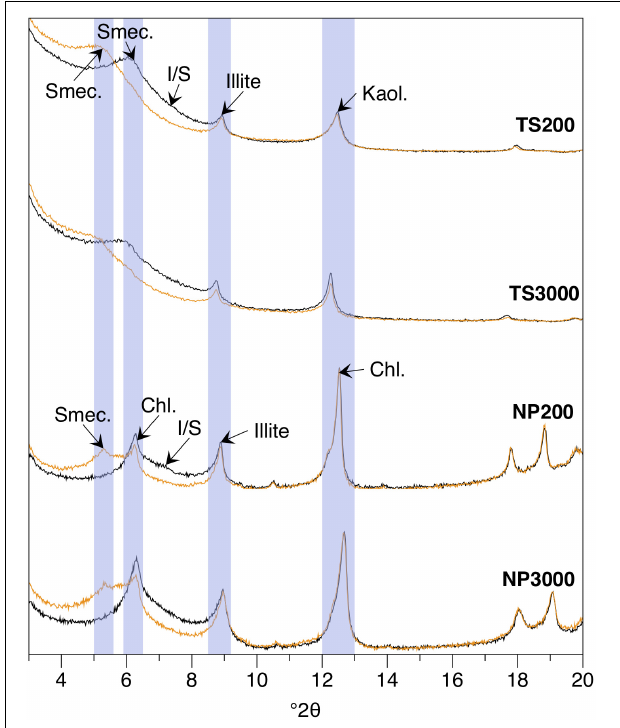
FIGURE 3 | Representative X-ray diffractograms of the air dried (black) and ethylene glycol-treated (orange) < 2 µ m fraction from the shallow and deep North Pacific and Tasman Sea sites. Peaks corresponding to smec., smectite; chl., chlorite; I/S, mixed-layer illite-smectite; kaol., illite and kaolinite are indicated. Bulk XRD information is provided in the Supplementary Material